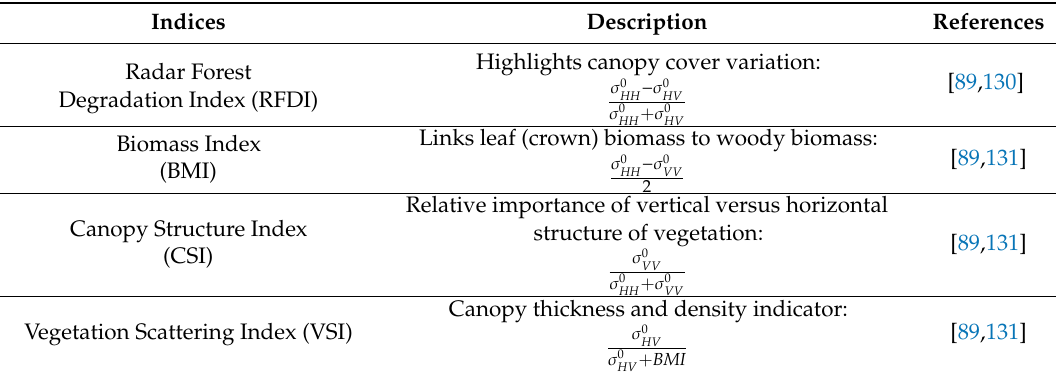
Table 4. Polarimetric indices used in the detection of tropical moist forest